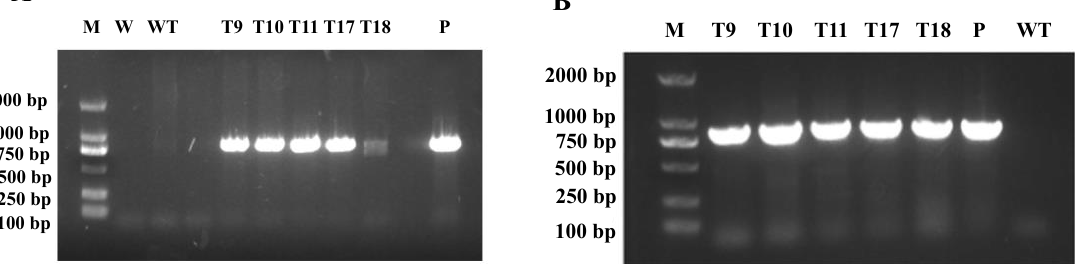
Figure 5. ( A ) PCR analysis of plant genomic DNA to confirm the presence of CgbZIP1 in trans- genic tobacco genome. M: Molecular-weight standard; W: water; WT: wild-type; P: pBI121- CgbZIP1 – GFP plasmid DNA. ( B ) RT-PCR analysis of CgbZIP1 expression in transgenic lines and wild-type (WT) controls. M: Molecular-weight standard; T9,10,11,17,18: CgbZIP1 transgenic lines; P: pBI121-CgbZIP1 – GFP.